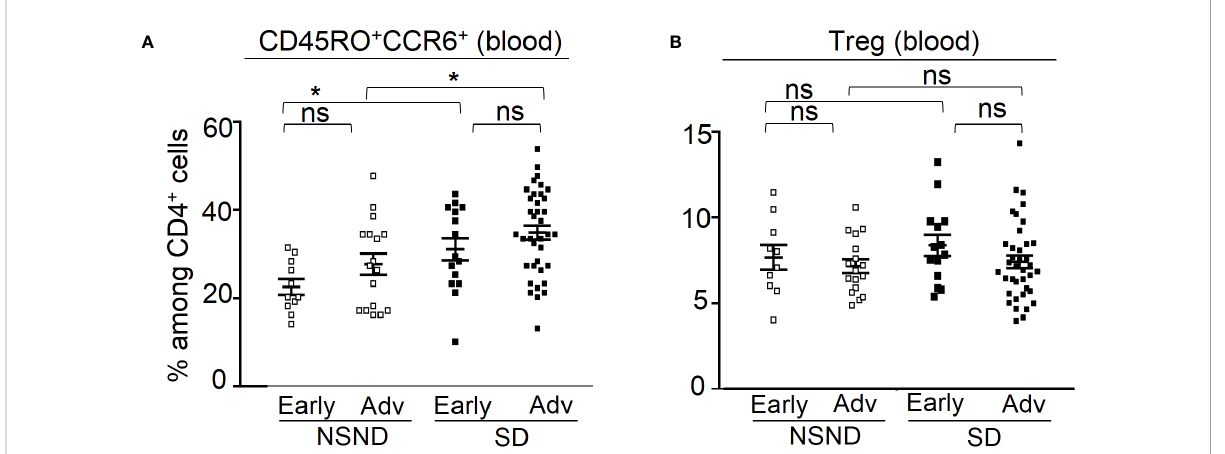
FIGURE 5 Analysis of circulating CD45RO + CCR6 + cells (left panel) and Treg (right panel) in patients at early and advanced OSCC stages. (A) The presence of circulating CD45RO + CCR6 + cells was analyzed in 28 NSND ( □ ) (11 early and 17 advanced stages) and 52 SD ( ■ ) (15 early and 37 advanced stages) OSCC patients. (B) The presence of circulating Treg was analyzed in 27 NSND ( □ ) (10 early and 17 advanced stages) and in 52 SD ( ■ ) (14 early and 38 advanced stages) OSCC patients were analyzed for Treg. Early stage: stages I and II; advanced stage (Adv): stages III and IV. For statistical analysis, a Mann-Whitney test was used. Bars represent the standard error of the mean (SEM). *p ≤ 0.05; ns: not signi fi